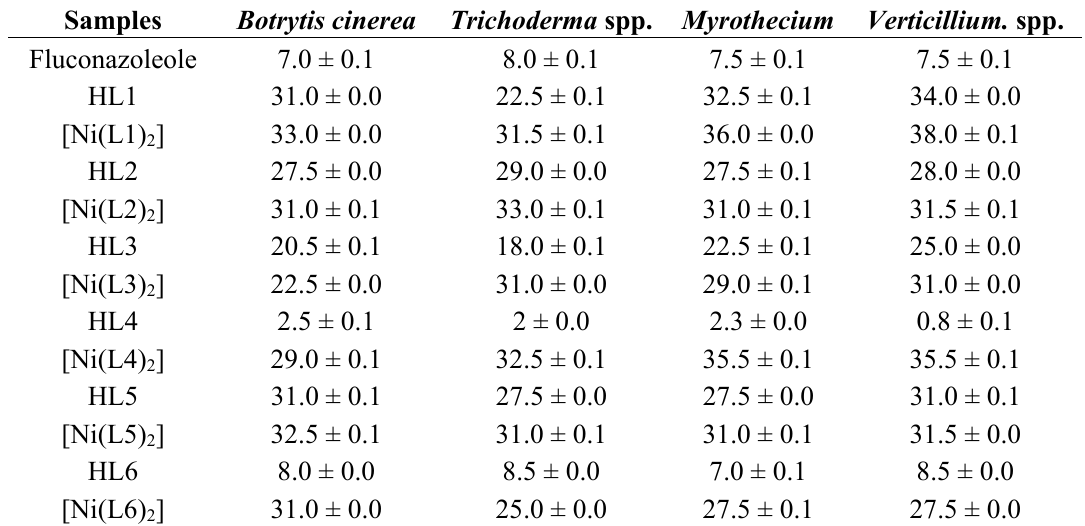
Table 3. The MIC of the ligands and their complexes against the studied fungi (SD: standard deviation).